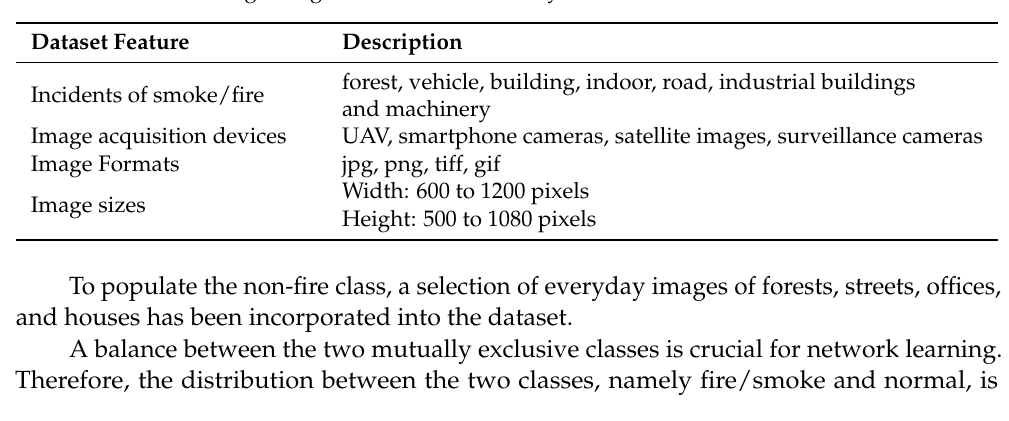
Table 2. Information regarding the dataset of the